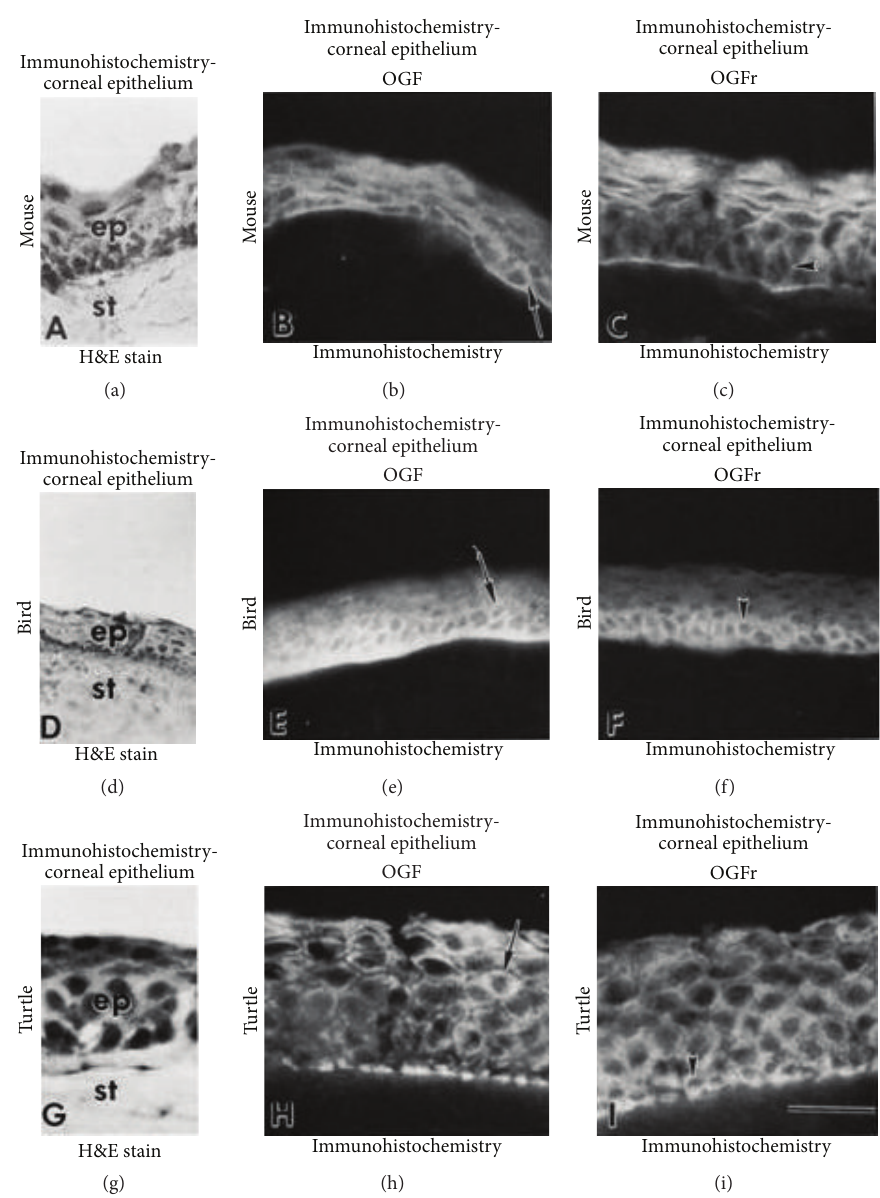
Figure 3: Immunohistochemistry for OGF and OGFr in mouse (a–c), bird (d–f), and turtle (g–i) corneal epithelium using brightfield (a, d, g) or indirect (b, c, e, f, h, i) immunofluorescence. Insets (a, d, g) are stained with hematoxylin and eosin and demonstrate the corneal epithelium (ep) containing basal and suprabasal cells with the underlying stroma (st). Immunofluorescence microscopy of tissue stained with anti- [ Met 5 ] -enkephalin (OGF) IgG (b, e, h) demonstrates OGF in the epithelial cortical cytoplasm of basal and suprabasal cells (arrows). Immunofluorescence of tissues stained with OGFr IgG (arrowheads in c, f, i) (derived from [5]).